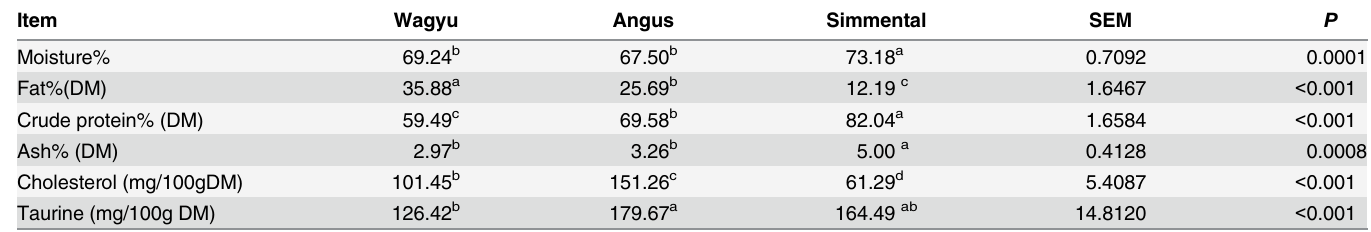
Table 1. Chemical composition of different breeds of beef.